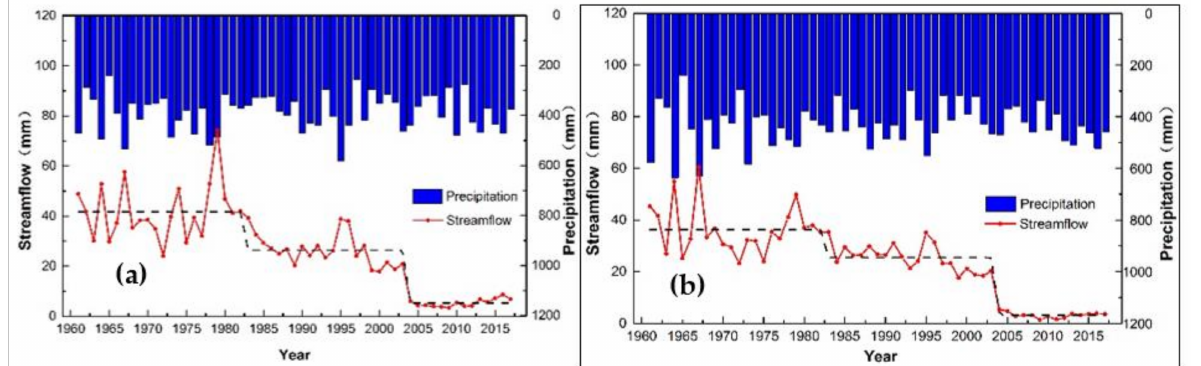
Figure 4. Temporal variations of annual streamflow (red line) and precipitation (blue column) for: ( a ) Xiangshuibu and ( b ) Shixiali.